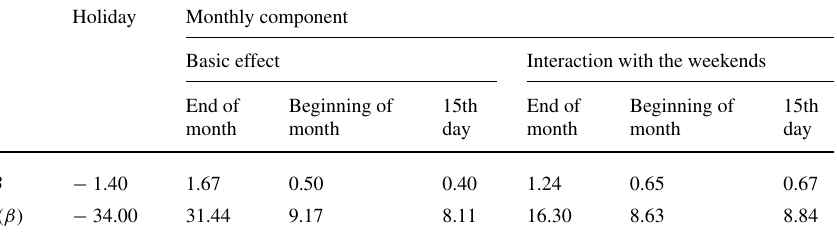
Table 1 Estimation of deterministic